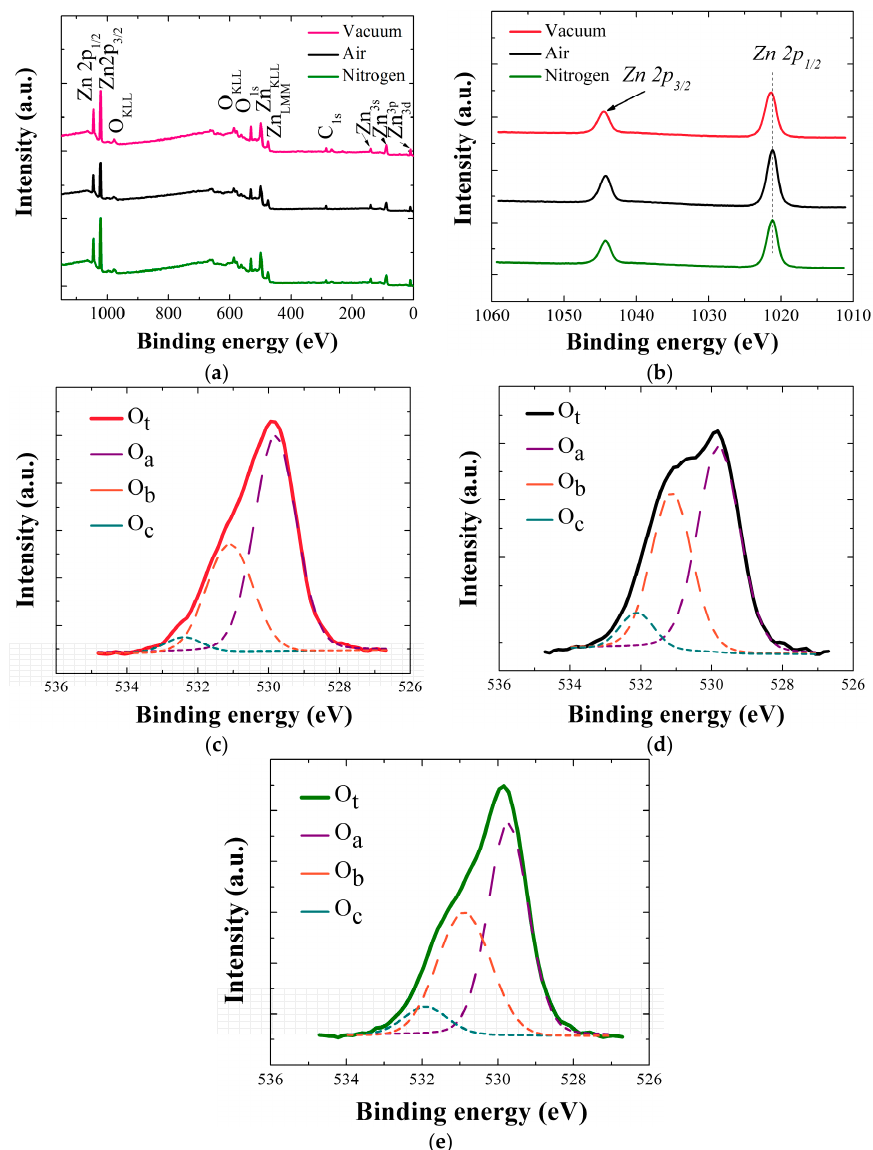
Figure 6. ( a ) Wide scan X-ray photoelectron spectroscopy (XPS) spectra of ZnO SLs annealed in three different ambients; ( b ) High resolution spectra of Zn-2p of the SLs; O1s core level spectra obtained from the ZnO SLs annealed in ( c ) vacuum; ( d ) air, and ( e ) nitrogen ambient are de-convoluted into three distant satellite